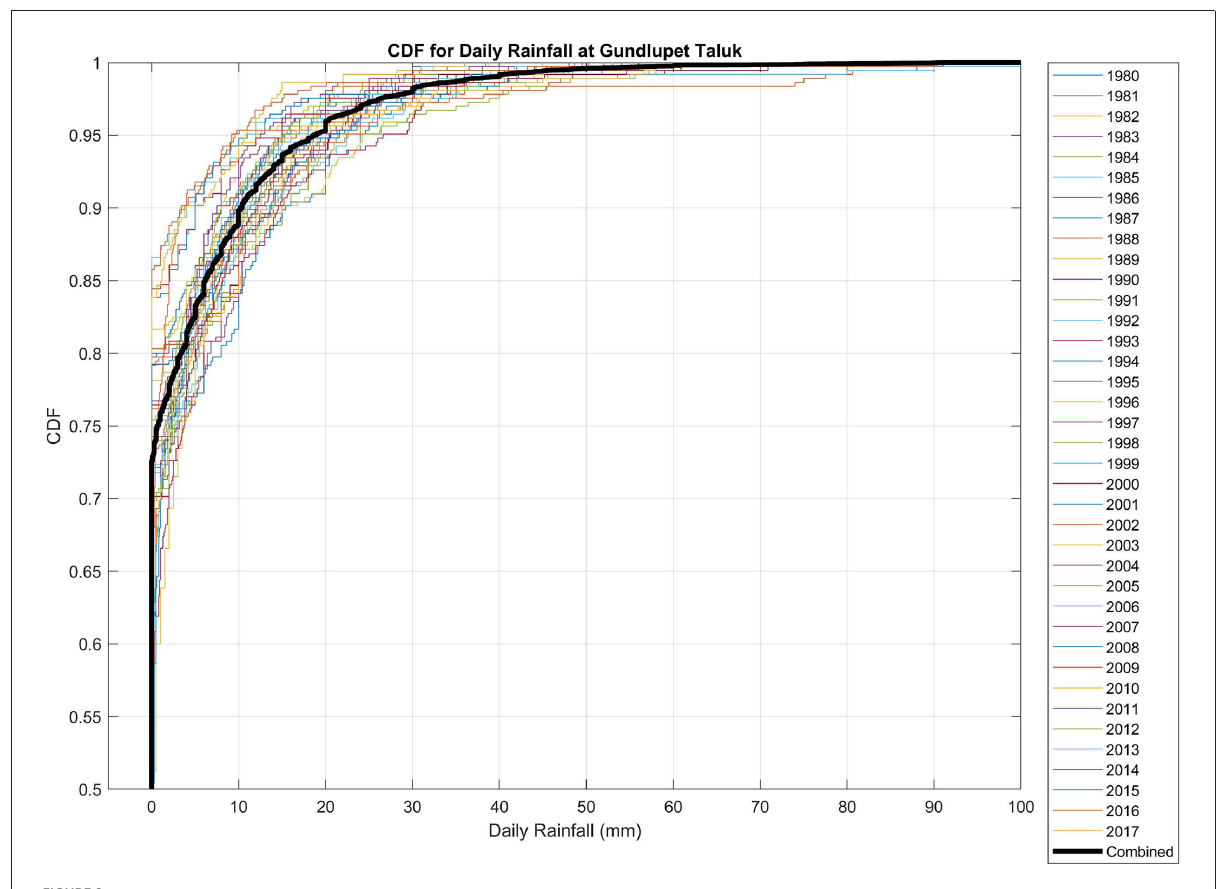
FIGURE2 Daily rainfall and mean CDF at Gundlupet